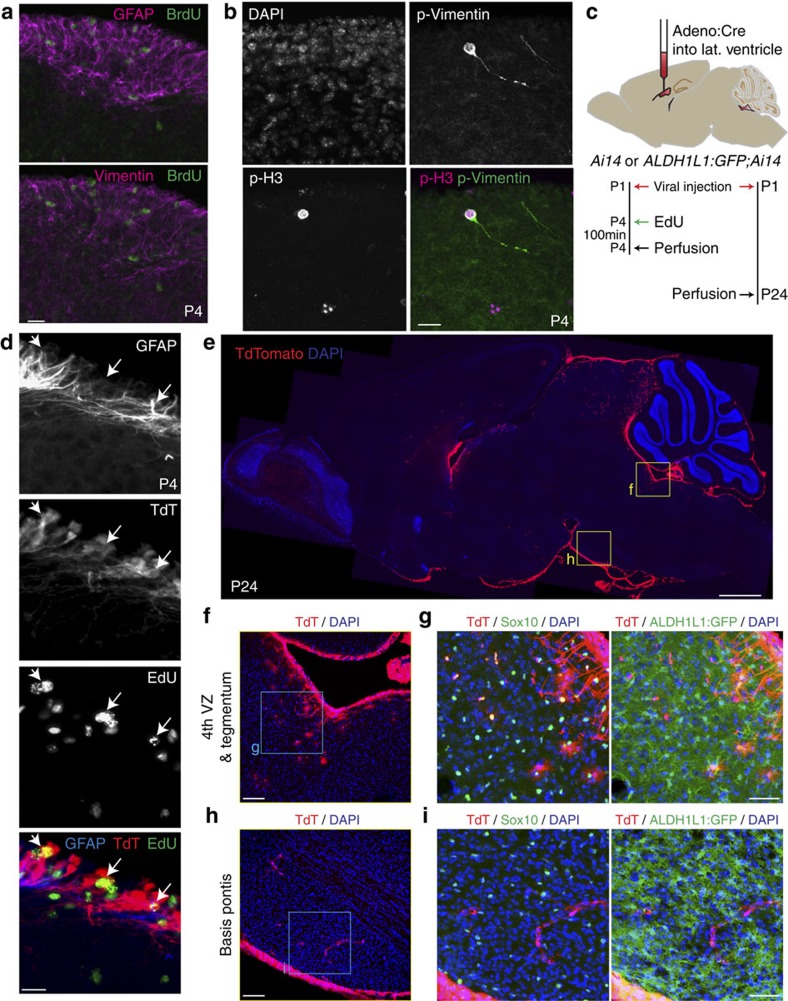
Properties and progeny of postnatal fourth VZ progenitor cells.(a) Wild-type mice received BrdU in a single dose 100 min before perfusion. BrdU+ nuclei in postnatal 4th VZ are surrounded by fibres of GFAP and vimentin. Scale bar, 20 μm. (b) Co-staining for M-phase marker phospho-histone-H3 (pH3) and phospho-ser55-Vimentin (p-Vimentin) reveals radial glial-like morphology of 4th VZ progenitors. Scale bar, 20 μm. (c–i) Viral fate mapping of postnatal 4th VZ progenitors. Ai14 or Ai14;ALDH1L1:GFP pups received Adeno-Cre viral injection in lateral ventricle at age P1, and were perfused at P4 (100 min after a single dose of EdU) or at P24. (d) Co-staining of P4 tissue sections for EdU, GFAP, and TdTomato reveals proliferative TdT+ nuclei in the VZ of the 4th ventricle. Scale bar, 20 μm. (e) Cre-recombined cells are visible in olfactory bulb, confirming successful targeting of forebrain V-SVZ progenitors; along the surface of the entire ventricular system, including pontine 4th ventricle; and along the ventral surface of the brain, suggesting viral outflow to meningeal space via cisterna magna. Scale bar, 1 mm. (f) Enlarged view of 4th VZ and pontine tegmentum region indicated in (e), revealing parenchymal TdTomato (TdT)+ cells. Scale bar, 100 μm. (g) Further enlargment of pontine tegmentum as indicated in (f), showing co-immunostaining for TdTomato (Red) and lineage-specific markers (Green: left, Sox10; right, ALDH1L1:GFP). Scale bar, 50 μm. (h) Enlarged view of basis pontis region indicated in (e), revealing parenchymal TdT+ cells. Scale bar, 100 μm. (i) Further enlargment of basis pontis as indicated in h, showing immunostaining for TdT and lack of colocalization with either Sox10 (left) or ALDH1L1:GFP (right). Many TdT+ cells are found along structures morphologically consistent with blood vessels. Scale bar, 50 μm.